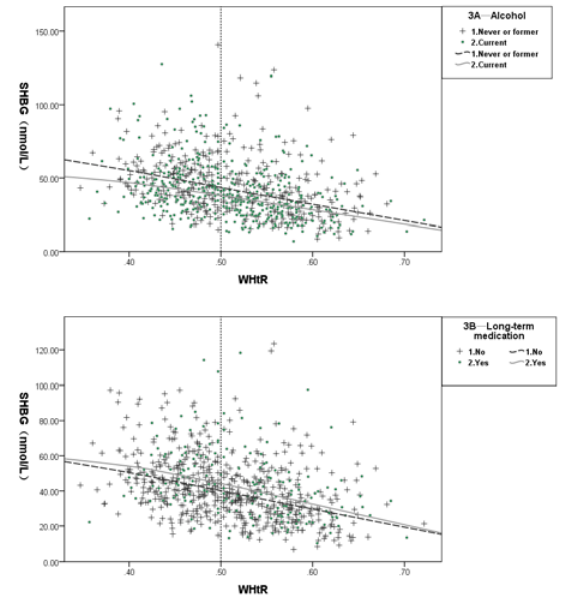
Figure 3: Relation between WHtR and SHBG level by life style charac- teristics (A) alcohol use and (B) long-term